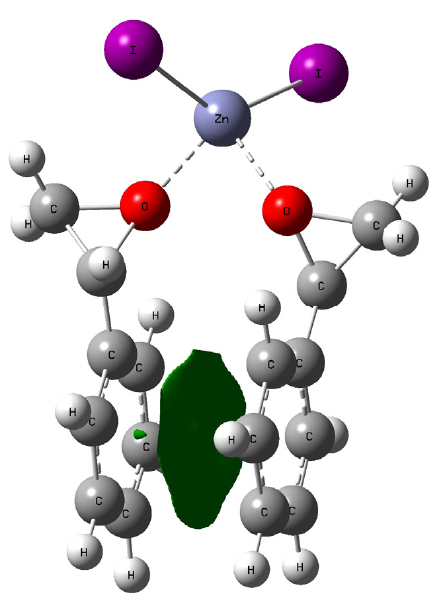
π - π interactions